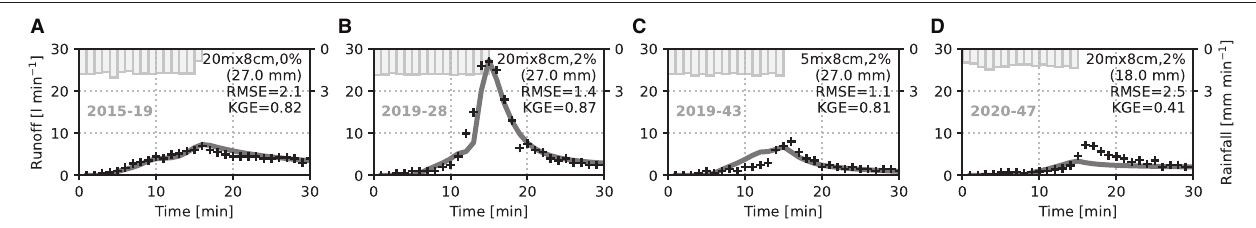
FIGURE 4 | Results of model calibration for the experiments (A) 2015–19, (B) 2019–28, (C) 2019–43, and (D) 2020–47. Each subplot shows time series of artificial rainfall (bars), observed runoff (plus symbol), and modeled time series (line). Moreover, dimensions, rainfall input, and skill measures used for computing the objective function are shown (RMSE computed for hydraulic head is given in